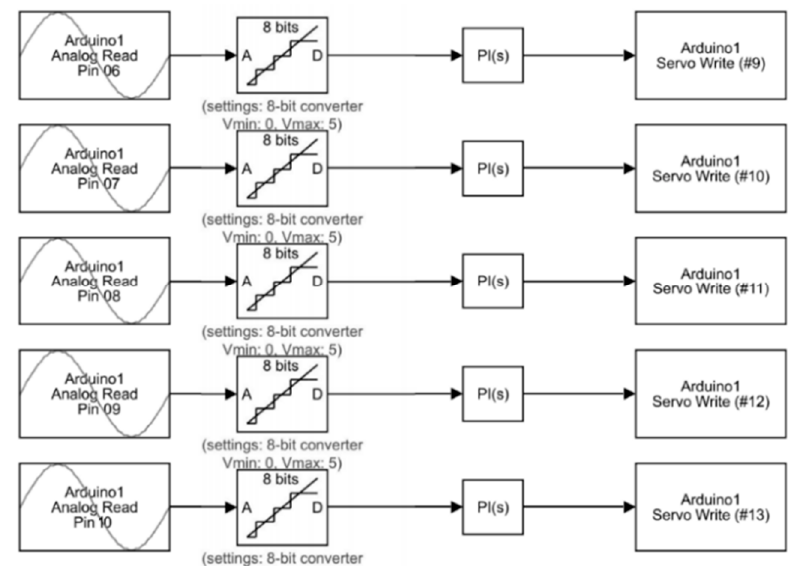
Figure 16. Control algorithm of FSR sensor implemented on Mega Pro.